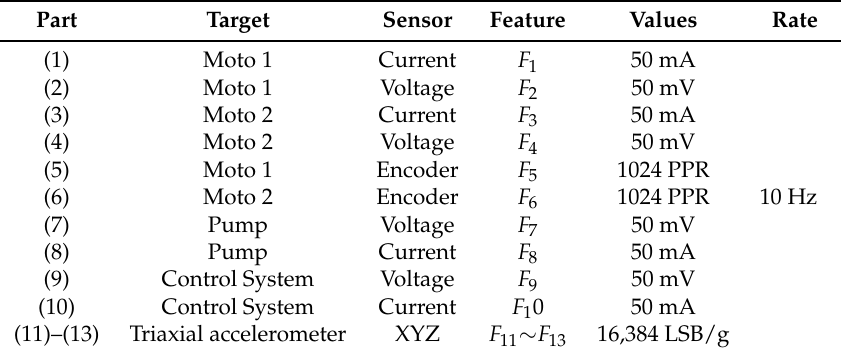
Table 4. Sensor parameter setting.